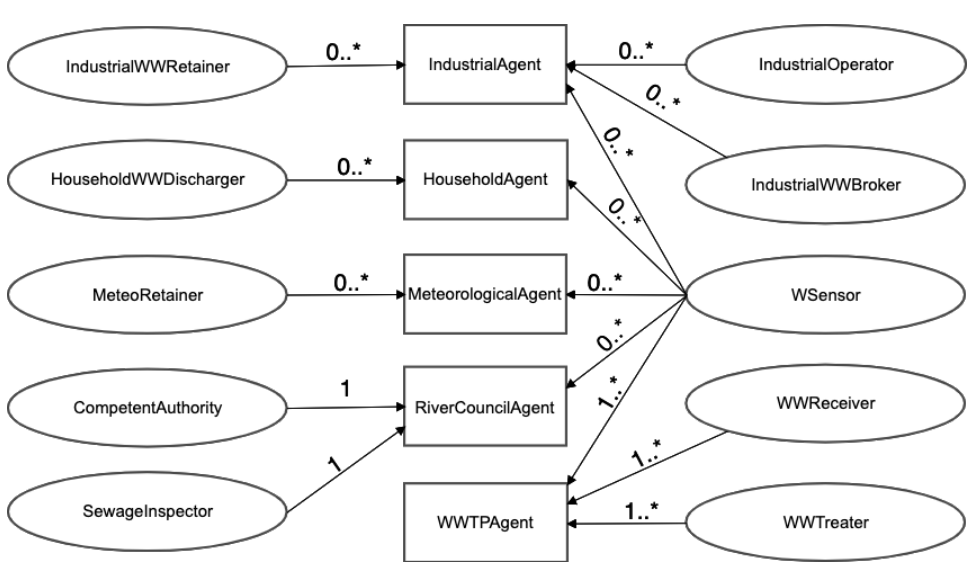
Figure 5. The social model defines the roles and the different types of agents that can play them. The * means that the amount of possible agents enacting this role can be